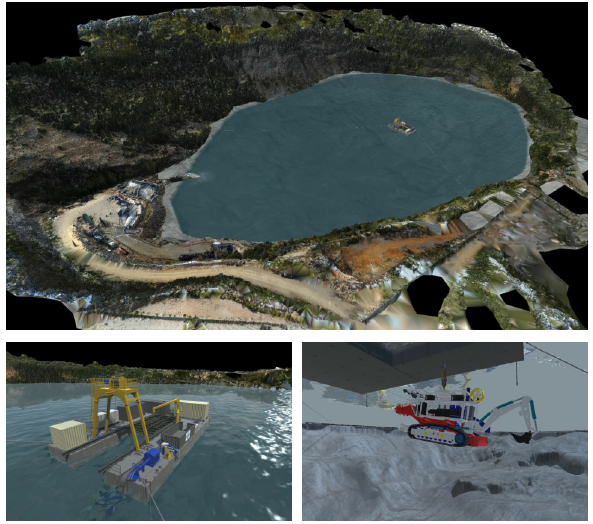
Figure 5. Model of the mining site in VR. Top: model of the mine with colored mesh of the above-the-water terrain, bottom: detail view of the launch and recovery vessel and the mining vehicle with underwater terrain